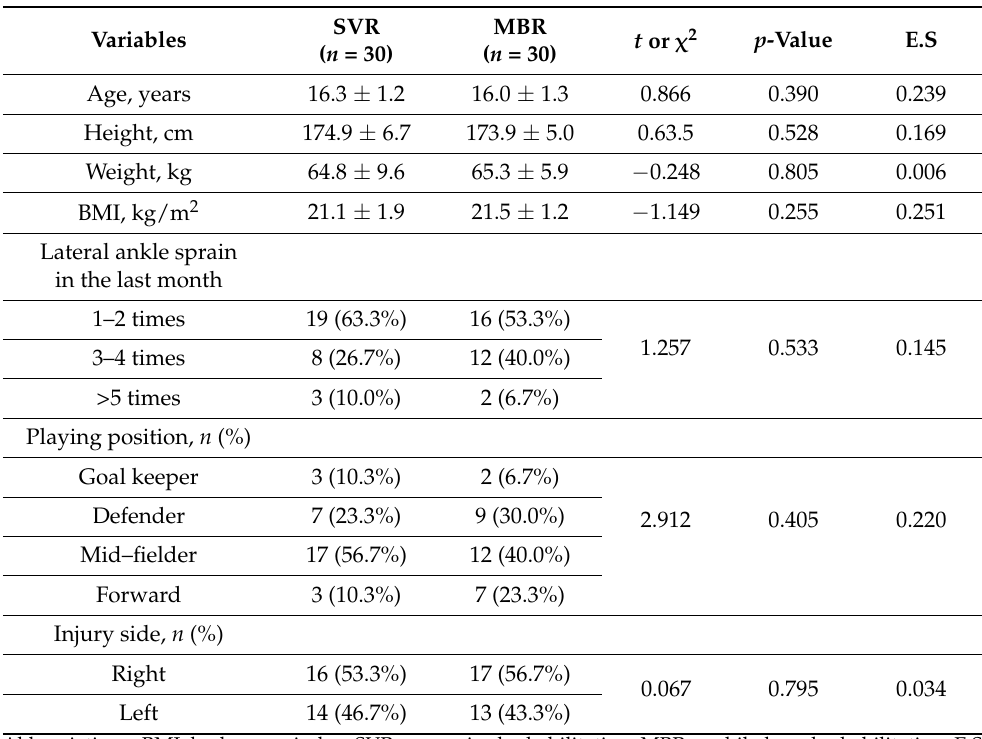
Table 2. General characteristics of